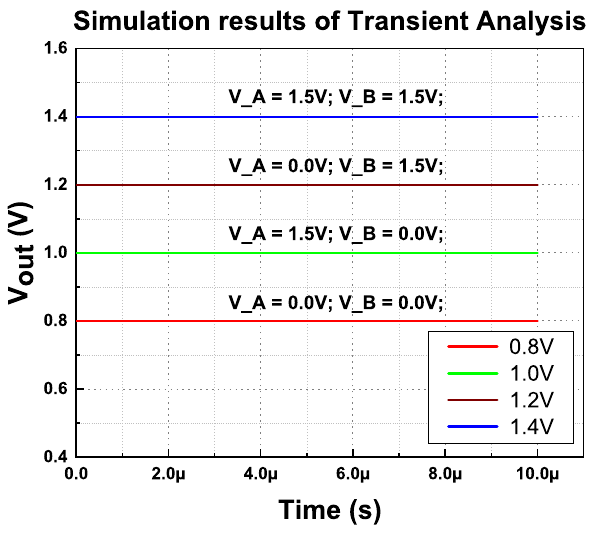
Figure 9. Simulation results of the MVD-LDO’s transient analysis. Based on the transient analysis simulation, the output voltage ripple was obtained. It is evident that without the external capacitor, the output voltage variation is significantly lower. Figure 10, employed the simulation results of the output voltage ripple for all four outputs during full-load conditions.